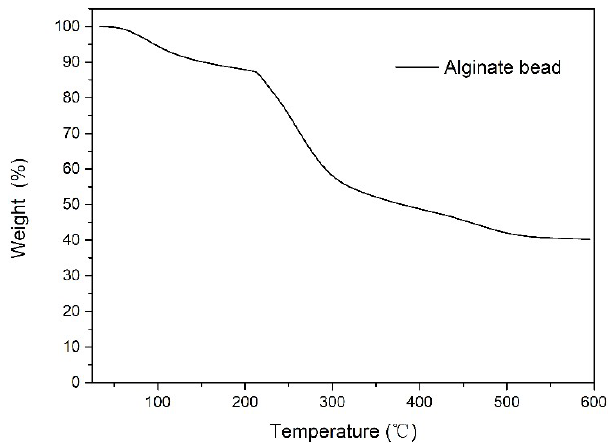
Figure 1. Scanning electron microscopy (SEM) images of the outer surface ( a – c ) and the internal structure ( d ) of the dried calcium alginate (CA) bead.